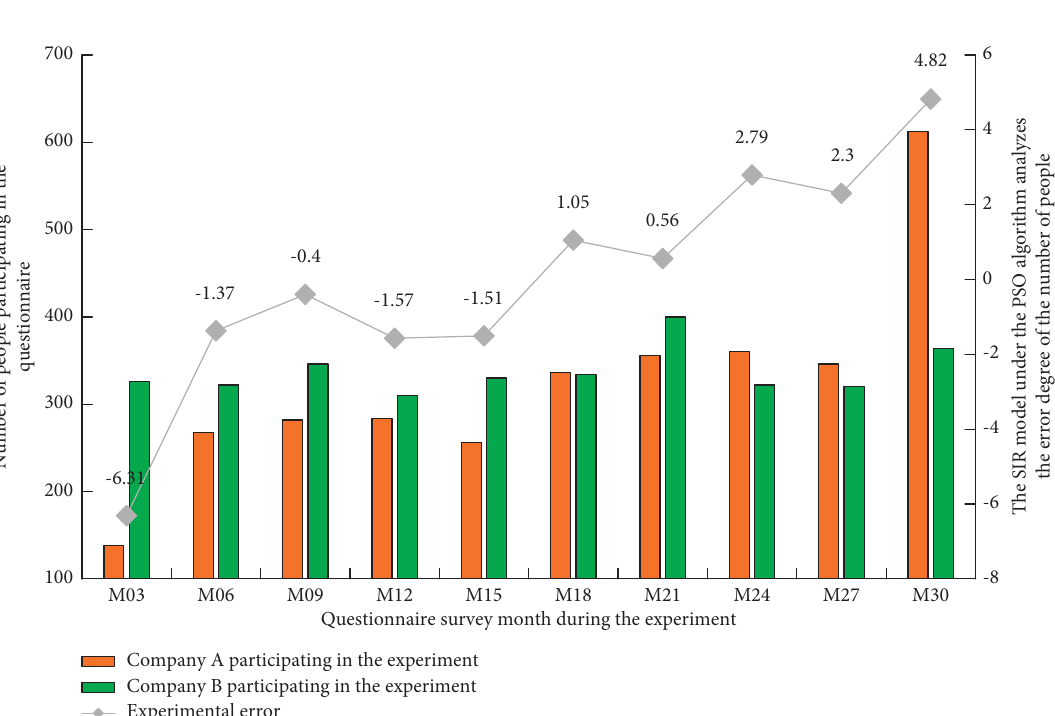
Figure 7: The judgment and analysis results of the changes of enterprise users based on the improved SIR model under the PSO algorithm.